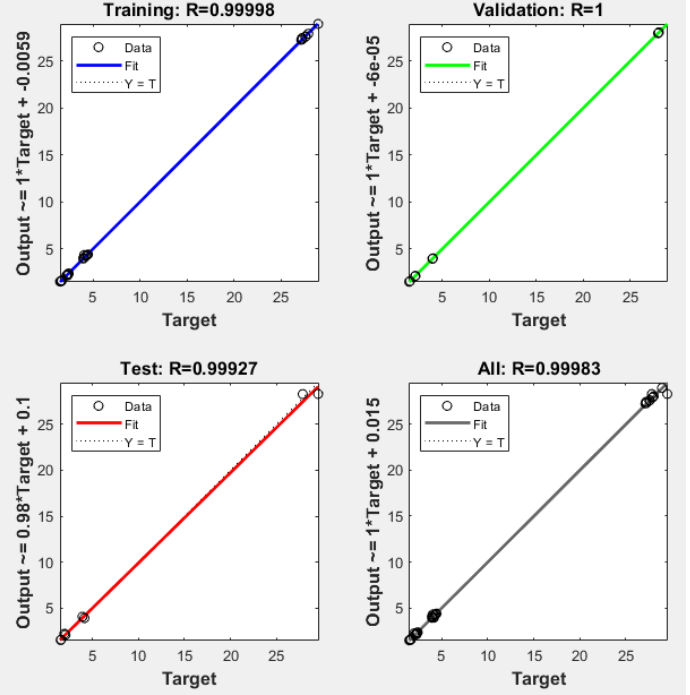
Figure 8. ANN output prediction in training, testing, and validating phase versus experimental results.